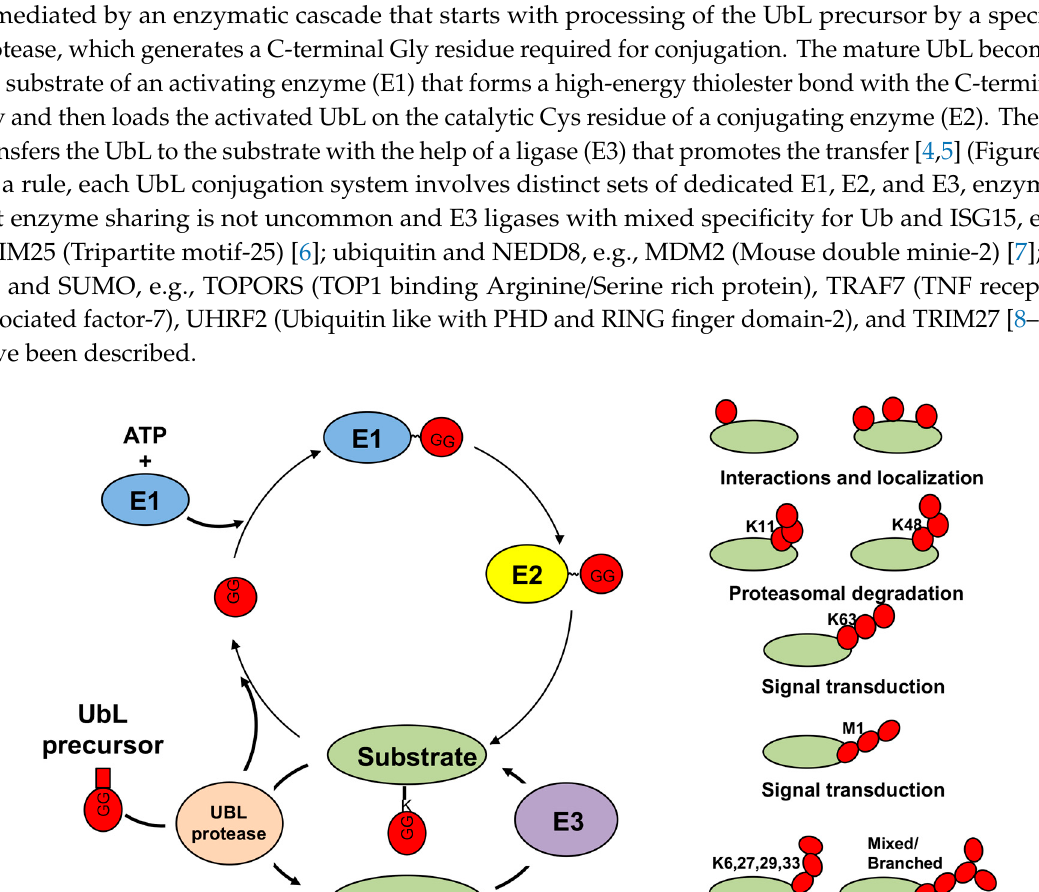
of a Ub moiety to the N-terminal Met1 or to an internal Lys residue of the previous Ub (K6, K11, k27,K29,K33,K48 or K63) results in the formation of topologically di ff erent poly-Ub chains that, upon recognition by signal transducers contain dedicated binding domains, target the substrates various fates and cellular